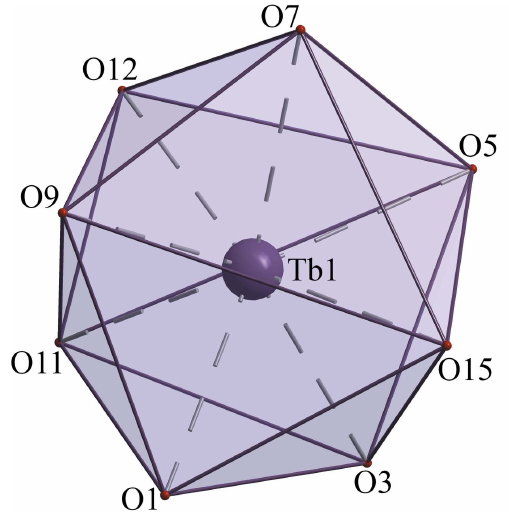
Figure 3 The Tb III coordination sphere geometry in 1